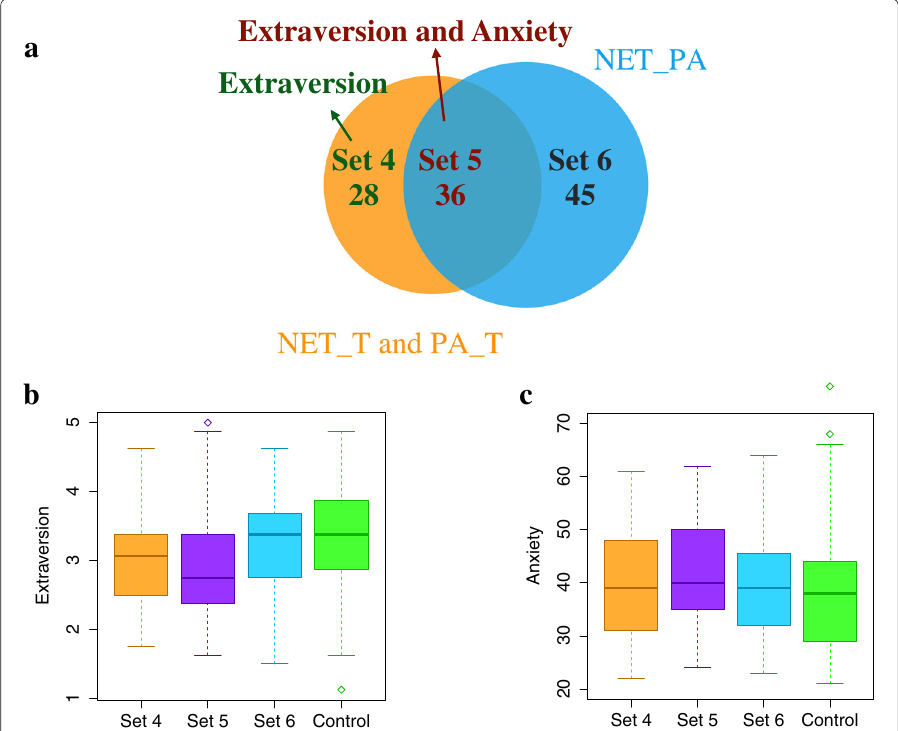
Fig. 10 Trait differences between NET_T ∩ PA_T (i.e., set 2 from Fig. 9), NET_PA and their subsets. a The overlap of NET_T ∩ PA_T and NET_PA. Set 4 denotes users who are in NET_T ∩ PA_T but not in NET_PA. Set 5 denotes users who are in both NET_T ∩ PA_T and NET_PA. Set 6 denotes users who are in NET_PA but not in NET_T ∩ PA_T b Boxplots of extraversion scores of user sets 4-6 and a control set, where the latter denotes users from CoU who are not in any of sets 4-6. c Boxplots of anxiety scores of the same user sets as in panel b